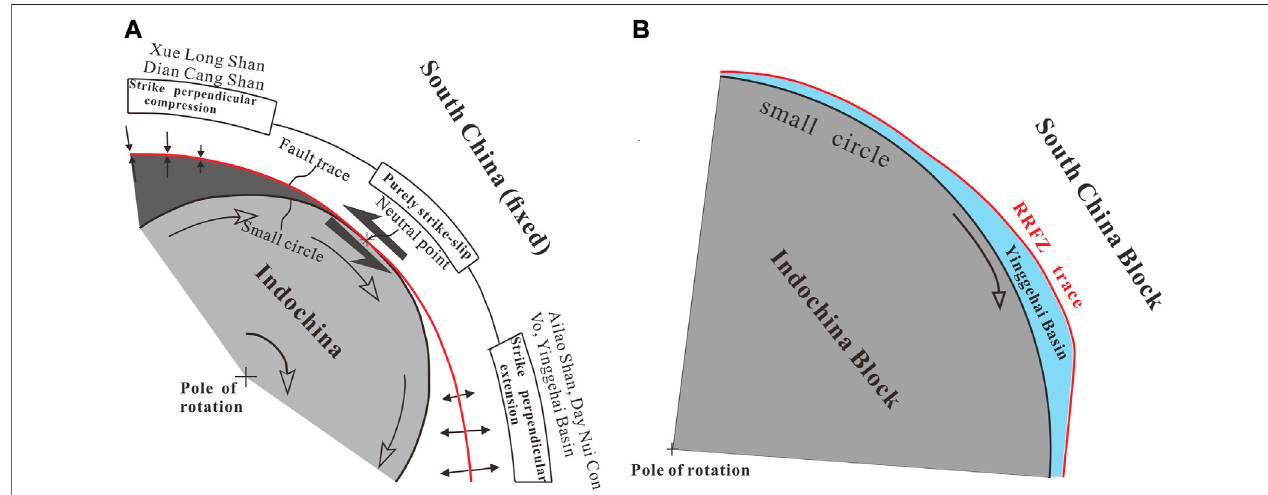
FIGURE 3 | Transrotational tectonics: (A) zipper tectonic model: the fault trace does not follow a small circle, resulting in transpression pure strike-slip and transtension (modi fi ed by Leloup et al. (2001)), and (B) analog model of the transrotational tectonics in the Yinggehai Basin.